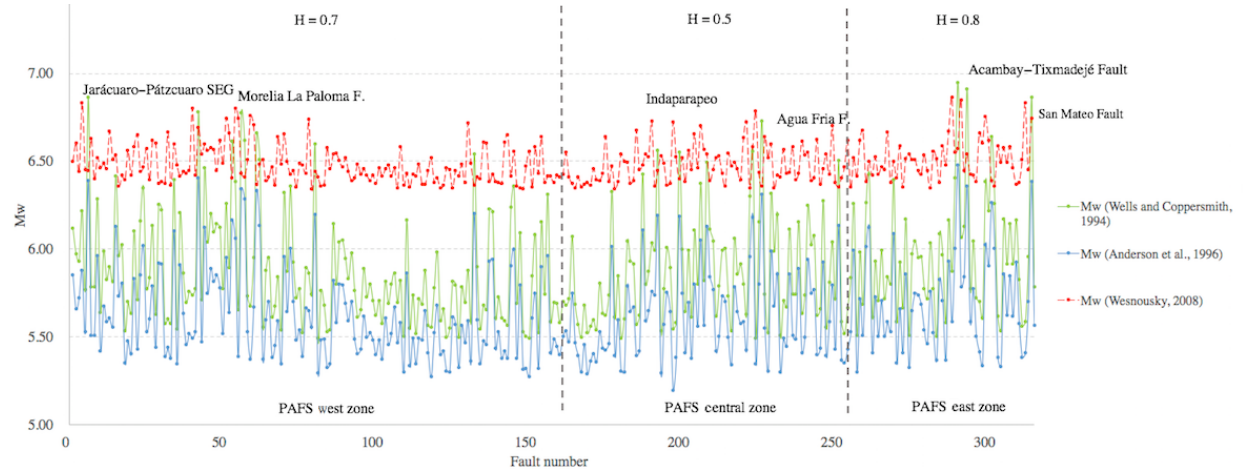
Figure 3. Firmagram roughness graph for the earthquake magnitude variations calculated by the surface rupture length (SRL) for the PAFS using: Wesnousky (2008, data in red); Wells and Coppersmith (1994, data in green), and Anderson et al. (1996, data in blue). By optical visualization we observed that Wells and Coppersmith (1994) and Anderson et al. (1996) are underestimating the data with respect to the magnitudes determined by the equivalent regression model proposed by Wesnowsky (2008). Dashed gray lines are delimiting the three zones that define the micro-regionalization of the PAFS (western PAFS, central PAFS, and eastern PAFS ) in terms of their Hurst exponent ( H w = 0 . 7 ,H w = 0 . 5 ,H w = 0 . 8 respectively), showing different seismic rates for each zone. Some fault names were printed in the figure.